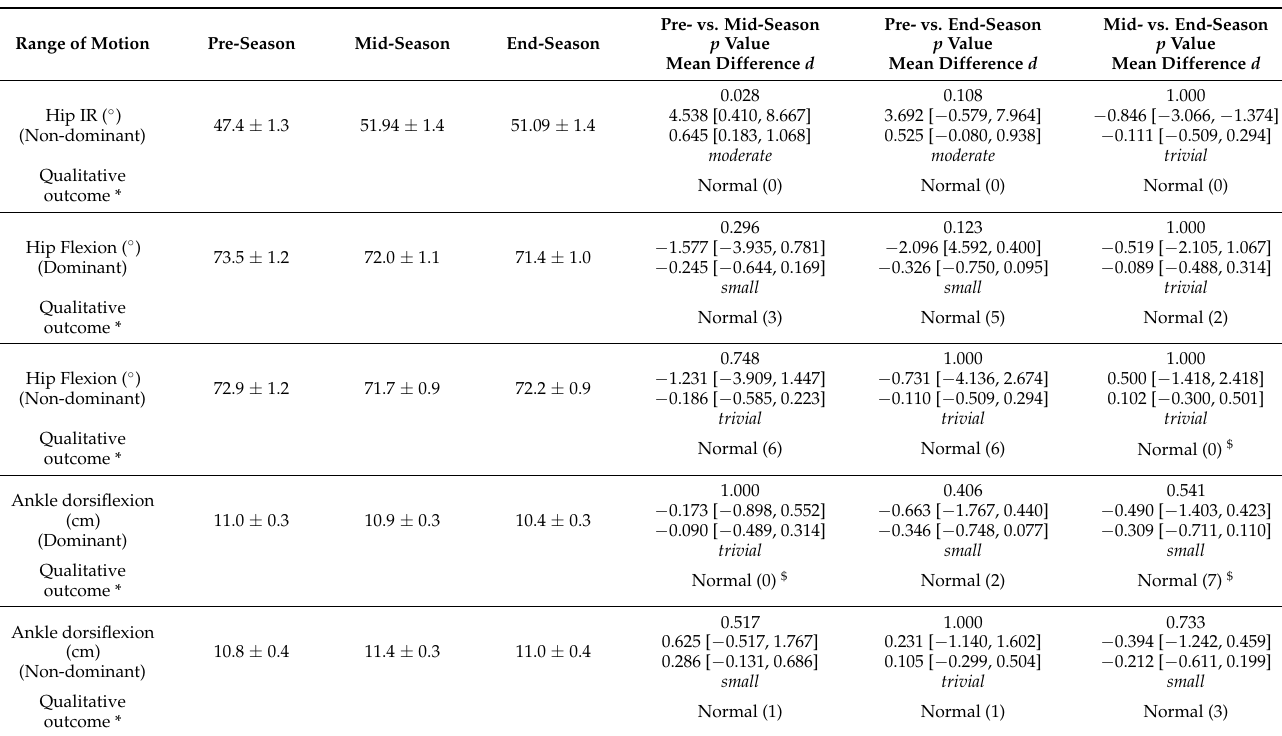
Abbreviations: d = Cohen’s effect size: Values between brackets are 95% confidence limits for mean difference and d . * Qualitative score of the mean range of motion, in parentheses the number of players with a restricted range of motion score according to previously published cut-off scores (see Section 2.5); $ = Depicts that the frequency of football players categorized as “normal” was different from the expected value at p < 0.05.